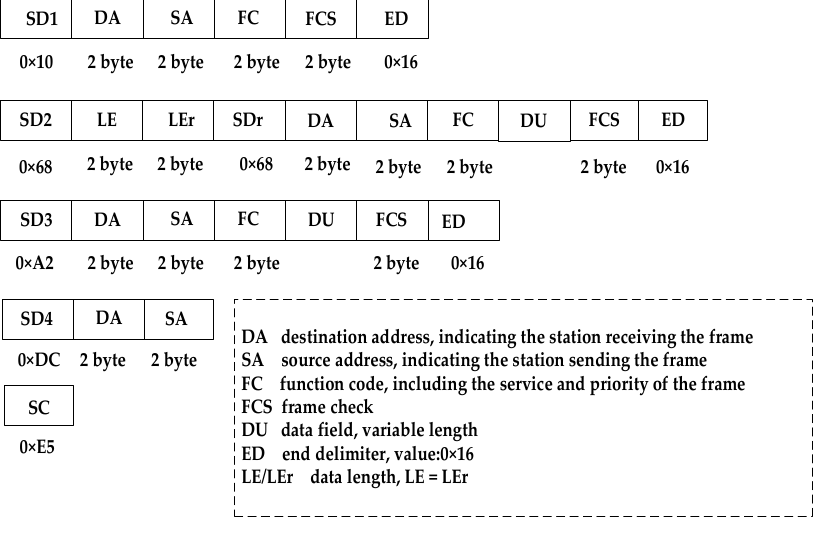
Figure 2. The five types of frames in the PROFIBUS-DP